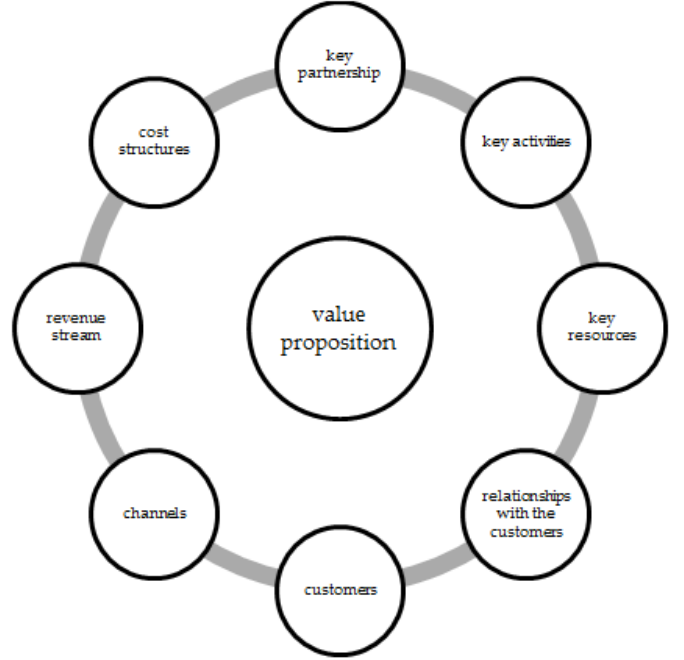
Figure 2. The building blocks including in business model canvas.